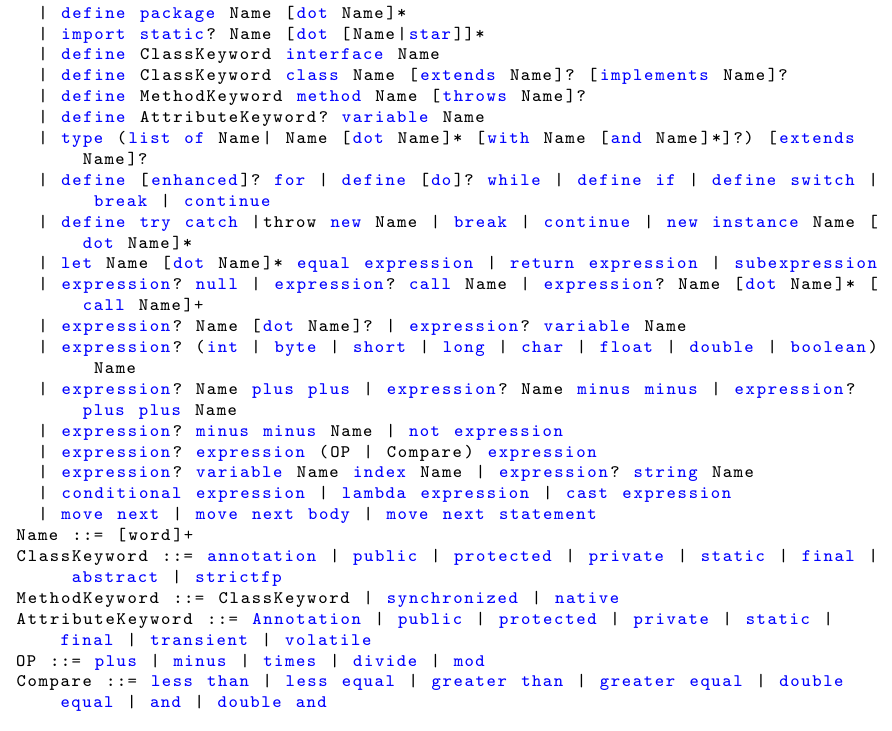
Figure 3. Overview of language syntax.